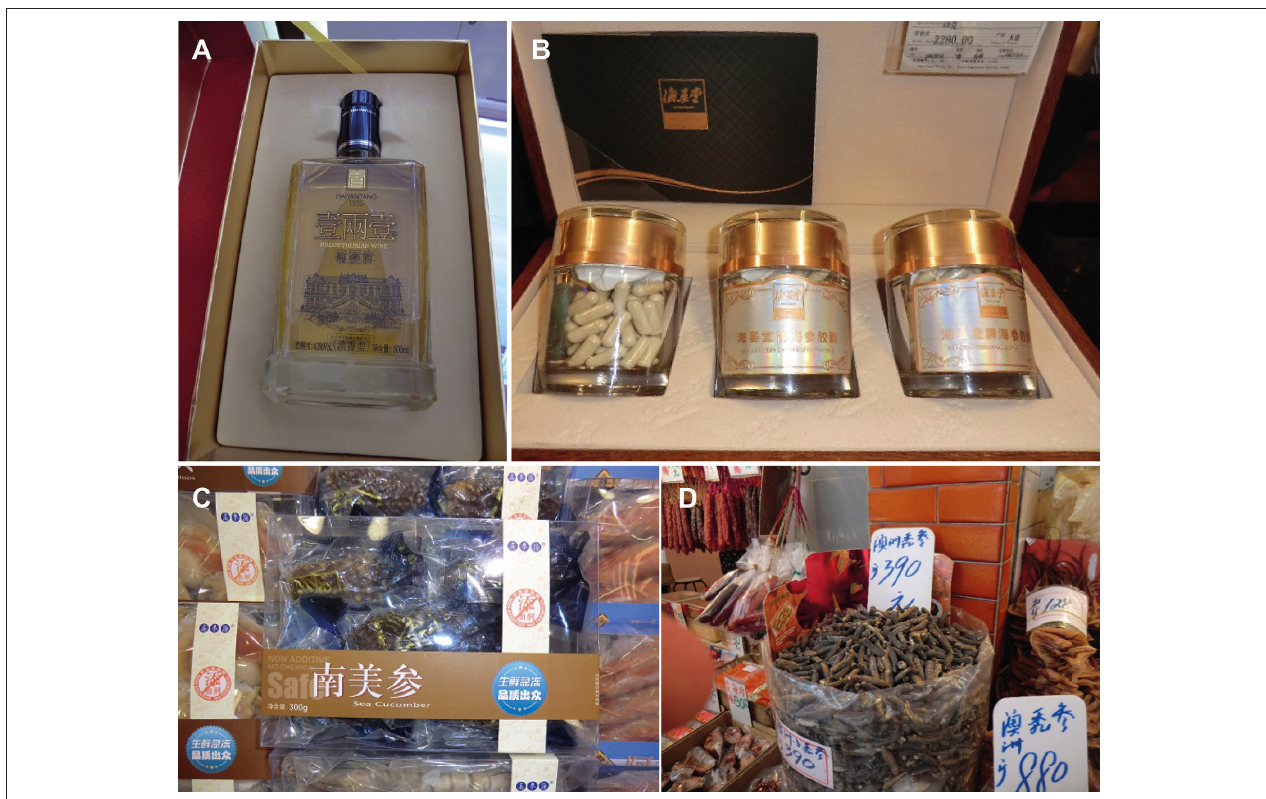
FIGURE 2 | Holothurian wine (A) ; capsules with contents of sea cucumbers (B) ; frozen sea cucumber from a supermarket (C) ; “Australian bald” sea cucumbers sold in Hong Kong (D) .